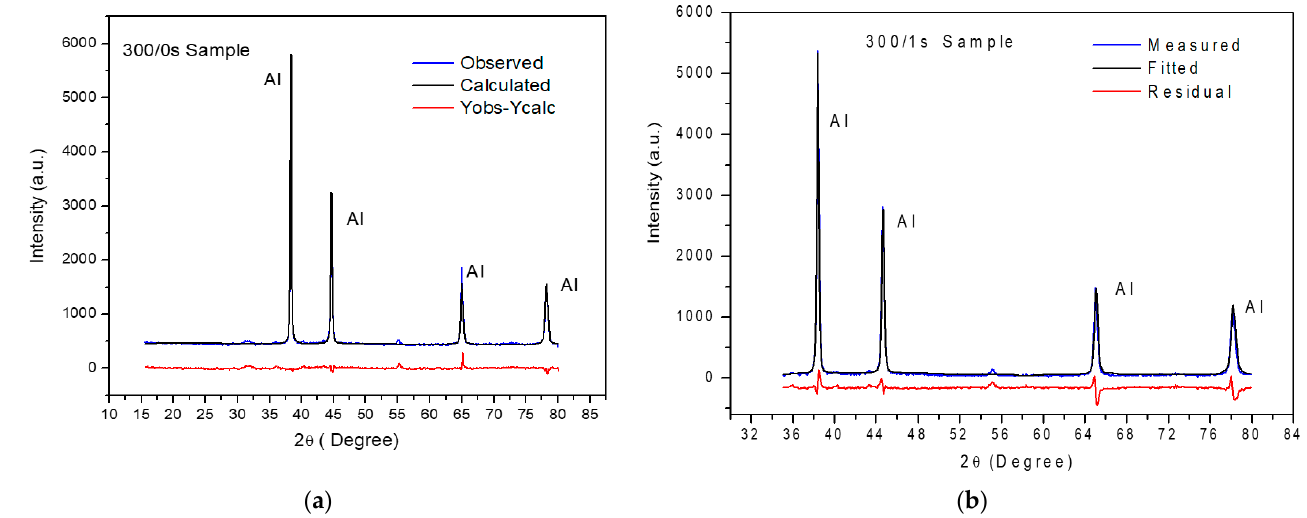
Figure 3. ( a ) The Rietveld refinement of the XRD pattern of the 300/0s sintered sample. ( b ) The CMWP fitting of the XRD pattern of the 300/1s sintered sample.